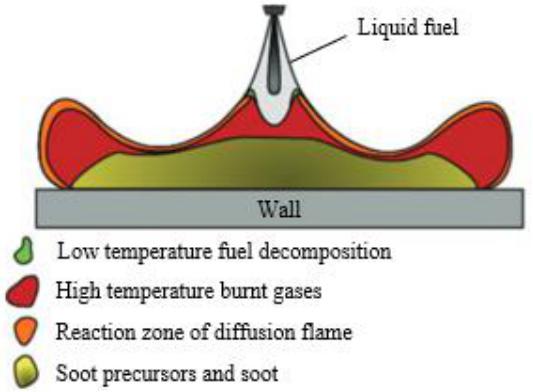
Figure 2. Schematic diagram depicting the conceptual model of diesel jet combustion in the jet-impinging-wall configuration during the stabilized diffusion-limited combustion phase [18].